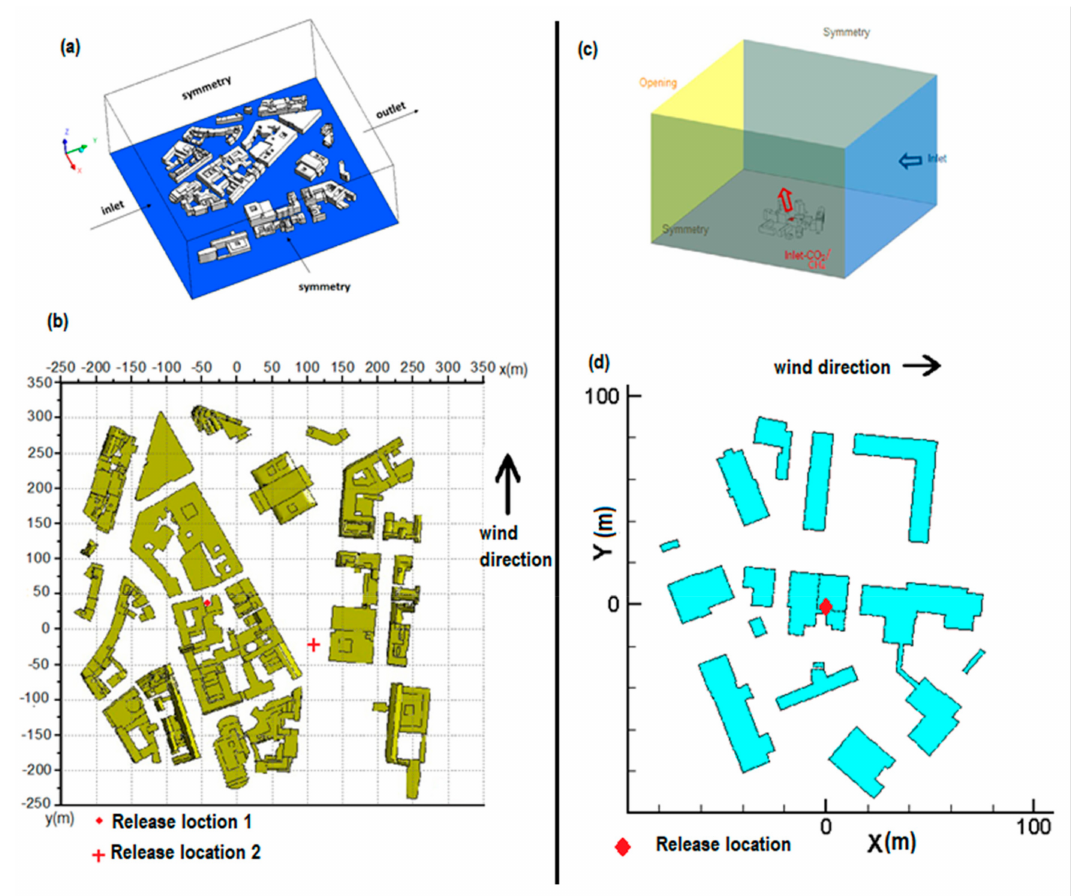
Figure 3. Geometry, boundaries conditions and release locations: ( a ) Geometry and boundaries conditions used for Hanover city, ( b ) Release locations used for Hanover city, ( c ) Geometry and boundaries conditions used for Frankfurt city, ( d ) Release locations used for Frankfurt